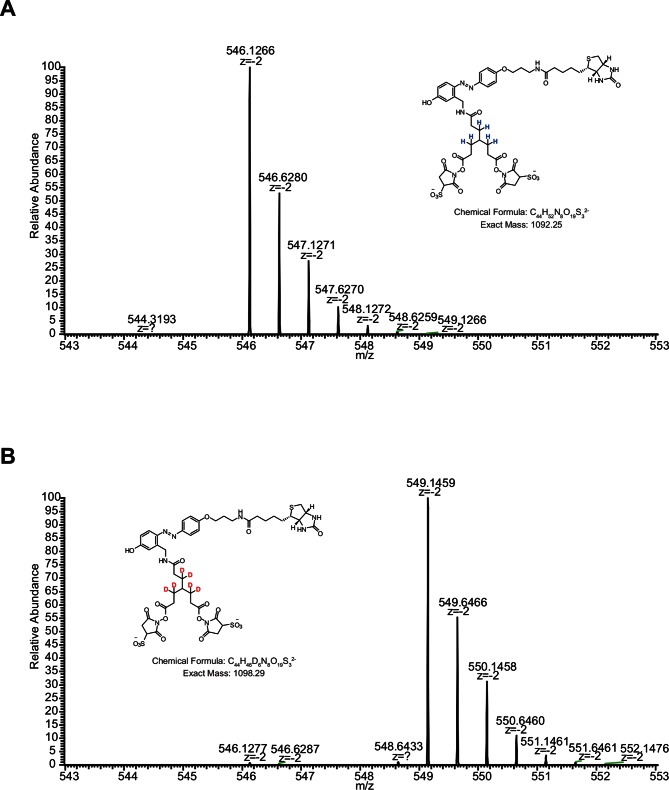
MS1 spectra of (A) [d0]-bAL2 and (B) [d6]-bAL2.